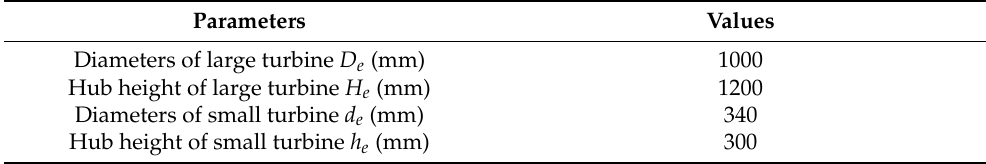
Table 4. Experimental wind turbine parameters.